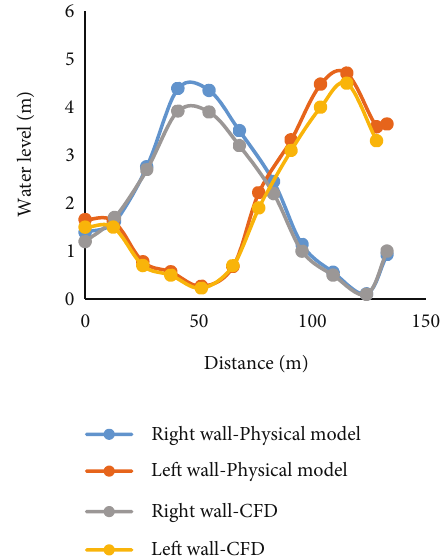
Figure 11: Level of water in the bottom